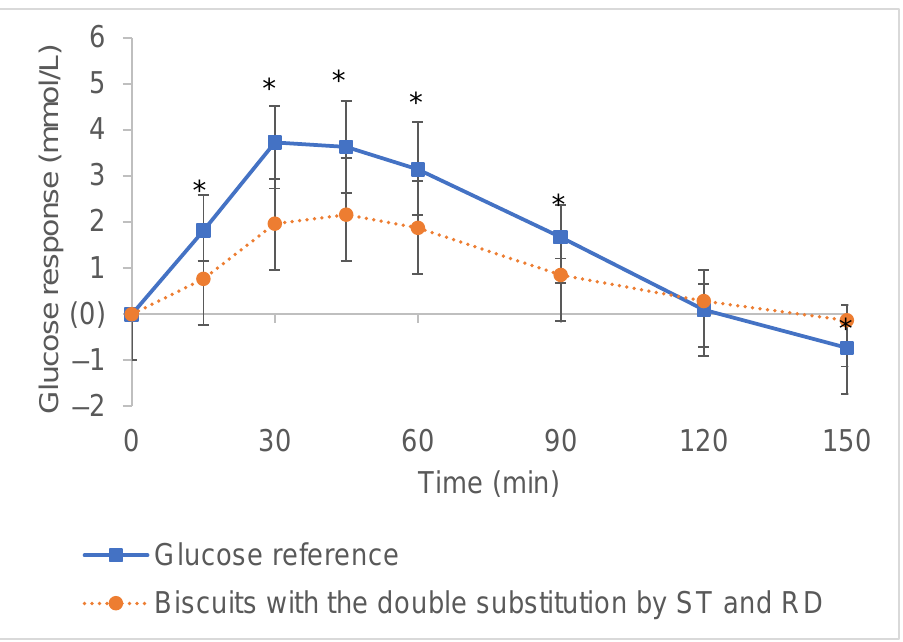
Figure 2. Postprandial blood glucose response curve of the biscuits with the double substitution by ST and RD. Significant difference at p < 0.05 between the biscuits and the glucose reference is signified by an asterisk (*) .